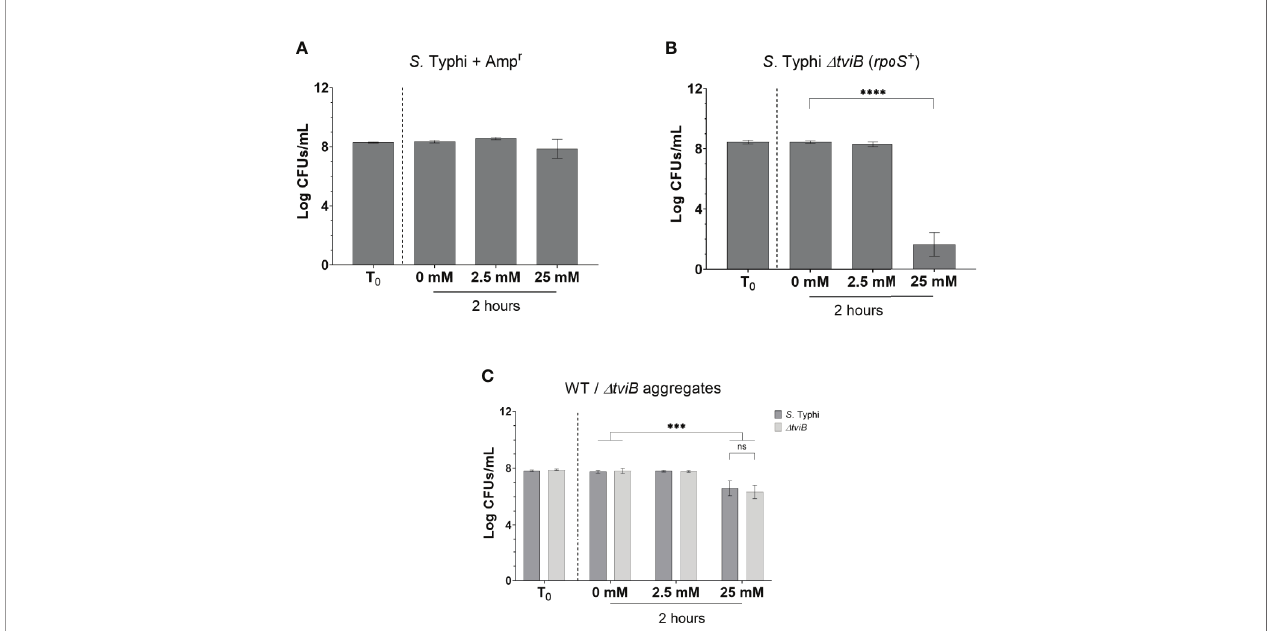
FIGURE 3 | Tolerance of single- and co-cultured S. Typhi bio fi lms to H 2 O 2 . (A) WT S. Typhi bio fi lm aggregates carrying an Amp resistance cassette were challenged with H 2 O 2 at a known tolerable dose (2.5 mM) and a challenge dose (25 mM). (B) S. Typhi D tviB bio fi lm aggregates were challenged in the same conditions as (A) . (A, B) Statistical signi fi cance was tested for/determined by one-way ANOVA with Dunnett correction for multiple comparisons (****p < 0.0001). (C) WT S. Typhi and S. Typhi D tviB bio fi lms were cultured in a 1:1 ratio, challenged with H 2 O 2 , and enumerated on differential antibiotic agar. Signi fi cance was tested with two-way ANOVA and Tukey correction for multiple comparisons (***p < 0.0005). No signi fi cant differences were observed between S. Typhi and S. Typhi D tviB at any one H 2 O 2 concentration. Each experiment was conducted in triplicate and the data represents the mean of three independent experiments. The error bars indicate